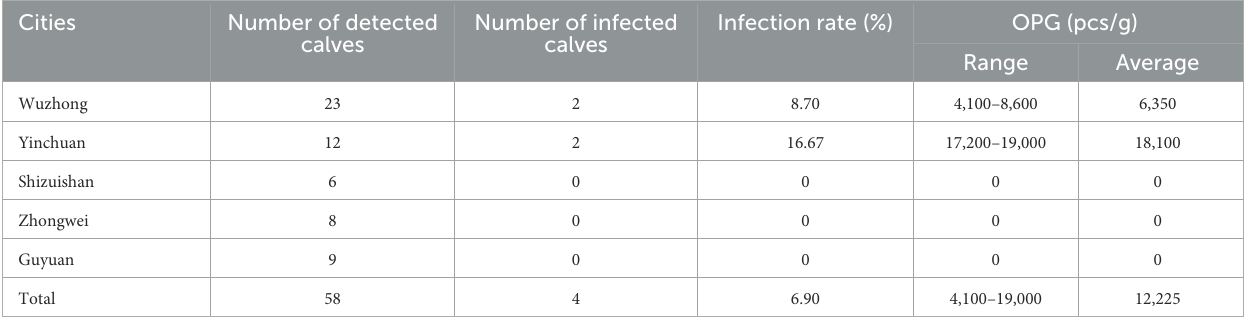
TABLE 3 The details of coccidia infections in calf diarrhea.